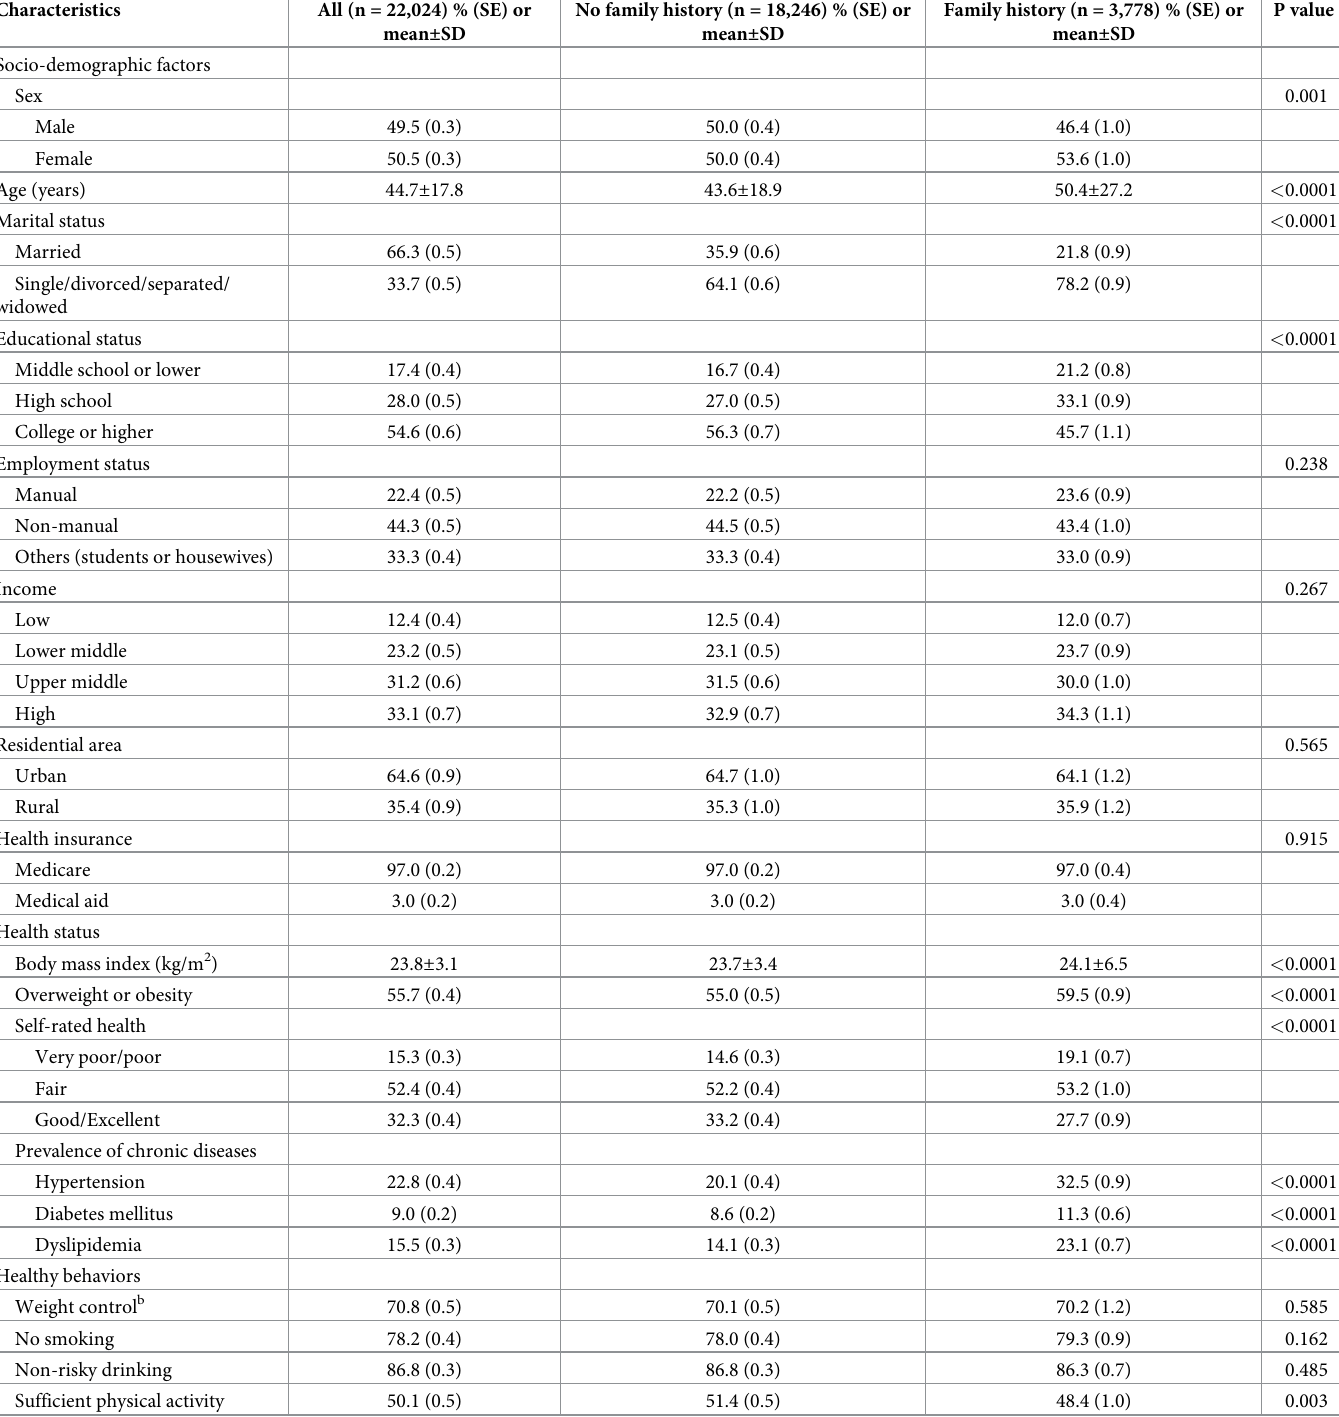
Table 1. Baseline characteristics of participants according to the family history of cardiovascular disease a .